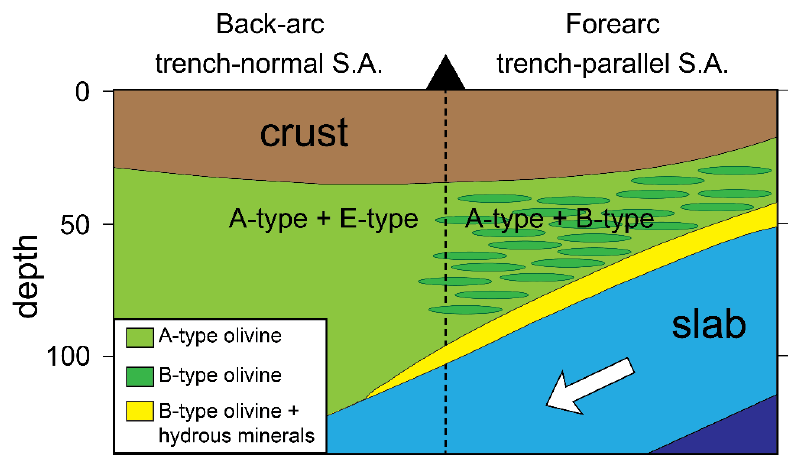
Figure 9. Schematic diagram of the proposed olivine fabrics in the mantle wedge of a cold subduction zone. Hydrous minerals: serpentine, chlorite, tremolite, etc. S.A.: Seismic anisotropy.